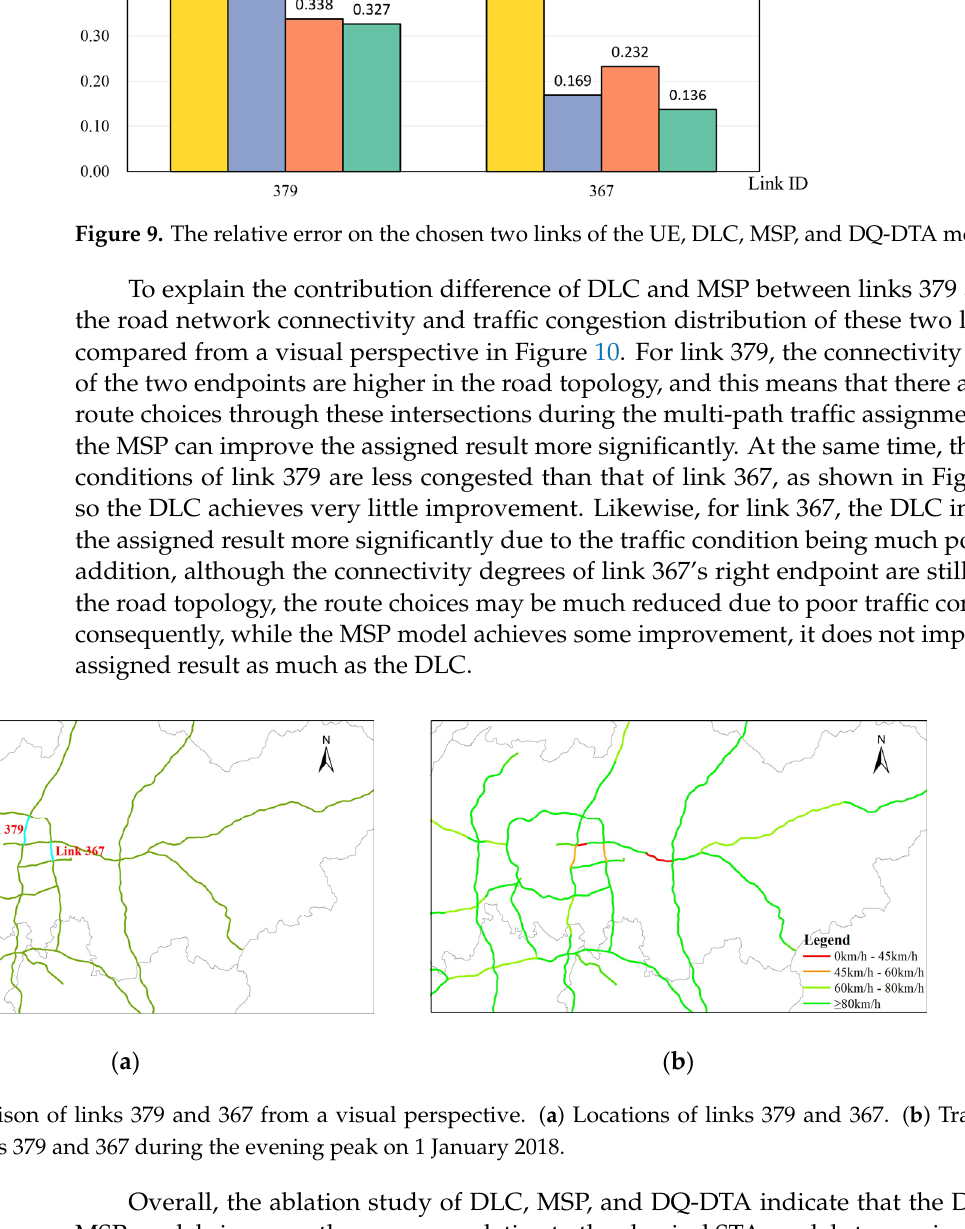
conditions near links 379 and 367 during the evening peak on 1 January